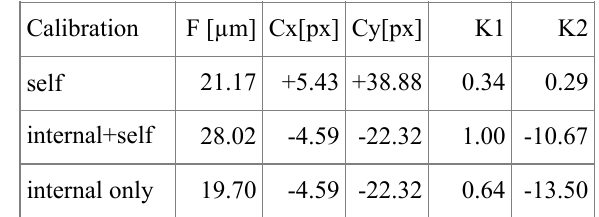
Table 2: Camera calibration results for test site "WSL Garten"